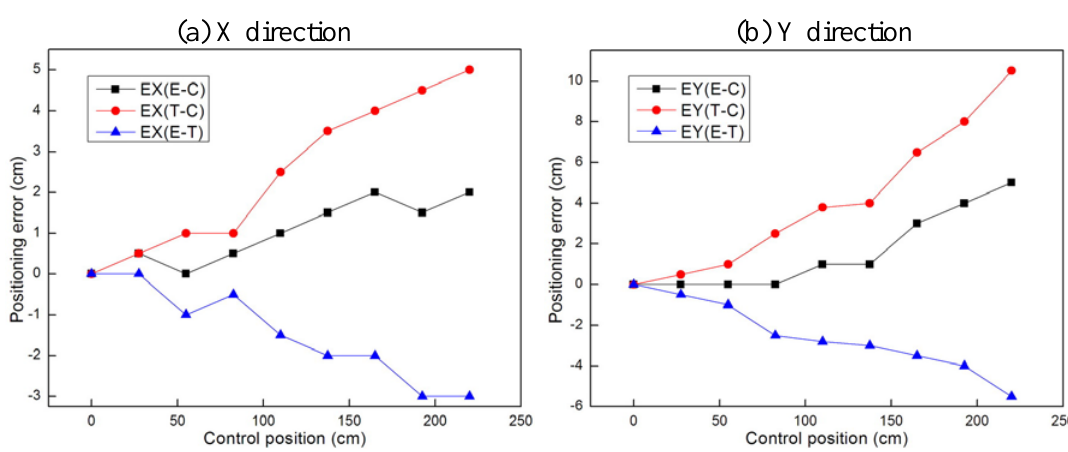
Figure 12. Error analysis of the straight-going